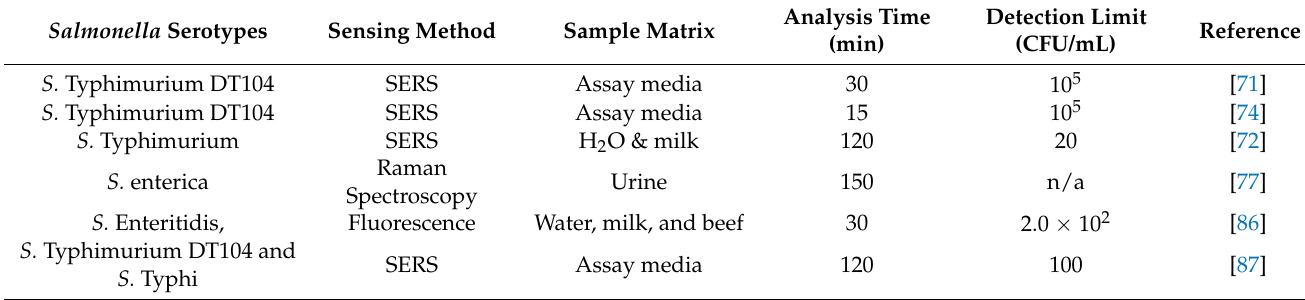
Table 1. Biosensors used in the detection of antibiotic-resistant Salmonella serotypes. SERS (surface enhanced Raman